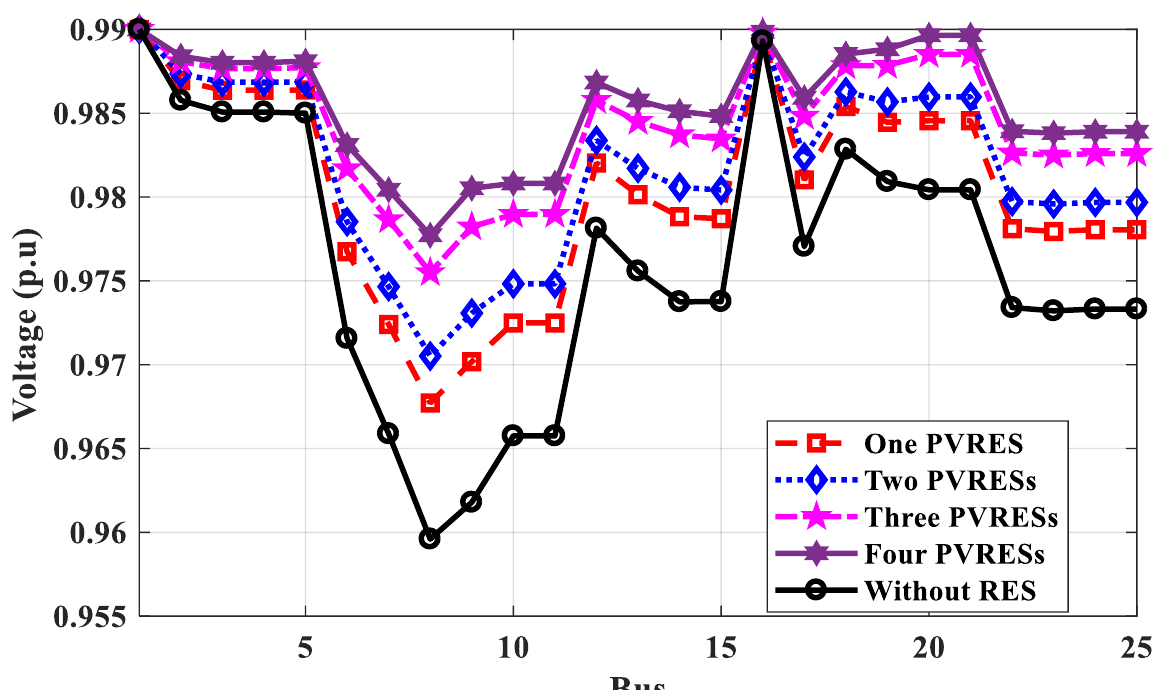
Figure 20. Voltage profile of 25-bus 500 kV EPS without and with PV systems for annual energy loss calculation.